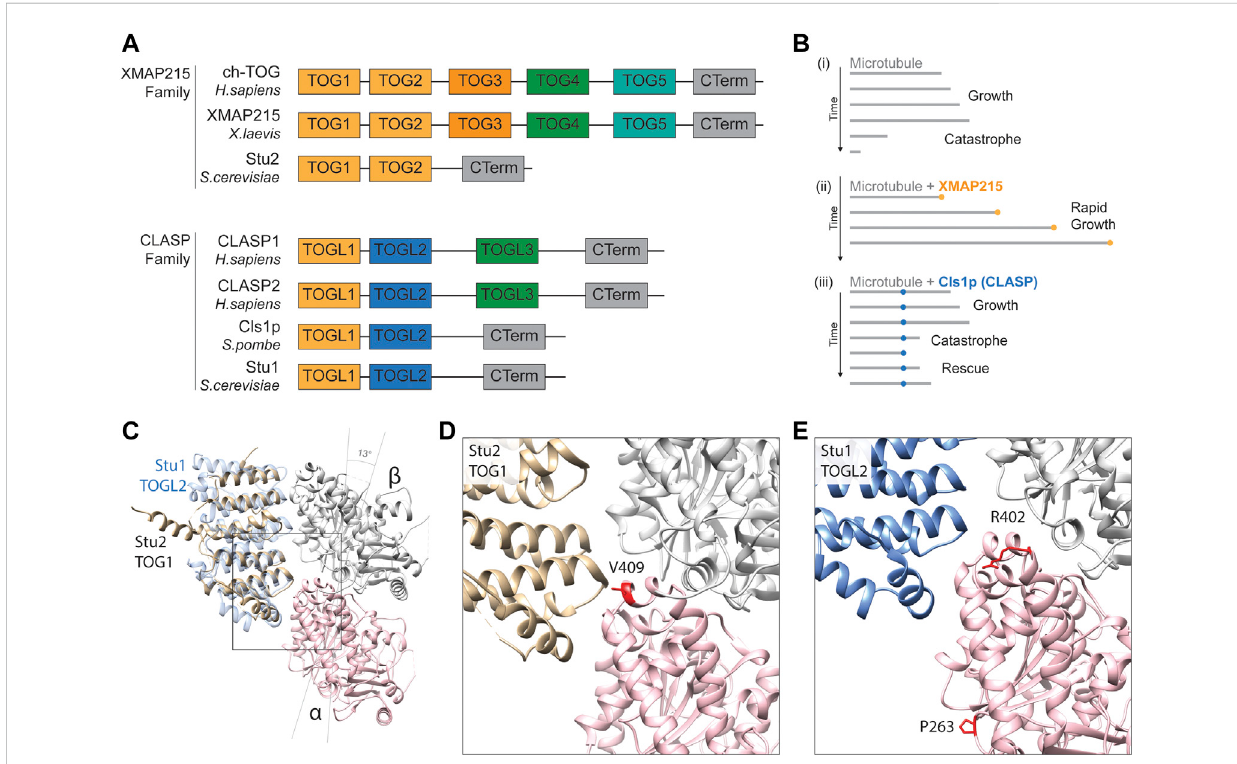
FIGURE 5 (A) SchematicalignmentandpositionalconservationofTOG domainsinXMAP215family microtubulepolymerasesandCLASPs[adaptedfrom(Al-Bassam and Chang, 2011; Byrnes and Slep, 2017)]. (B) Schematic depiction of dynamic behaviour of (i) pure microtubules (grey lines), (ii) accelerated microtubule polymerisationinthepresenceofXMAP215familypolymerases(gold),and(iii)microtubulerescuemediatedby fi ssionyeastCLASP,Cls1p(blue),adaptedfrom(Al- Bassam and Chang, 2011). (C) Homology model depiction of a unpolymerised tubulin heterodimer complexed with TOG1 domain of S. cerevisiae microtubule polymerase Stu2 (gold) (PDB 4FFB) and docked TOGL2 domain of Stu1 ( S. cerevisiae CLASP; blue) (PDB 6COK) (Ayaz et al., 2012; Majumdar et al., 2018). α -tubulins are represented by a pink ribbon, β -tubulins in silver. Both TOGs bind preferentially to curved tubulin heterodimers, hence α - and β -tubulin subunits are tilted 13 to form this complex (Ayaz et al., 2012). (D) A detailed view of the predicted TOG1 binding interface of tubulin heterodimers. The α